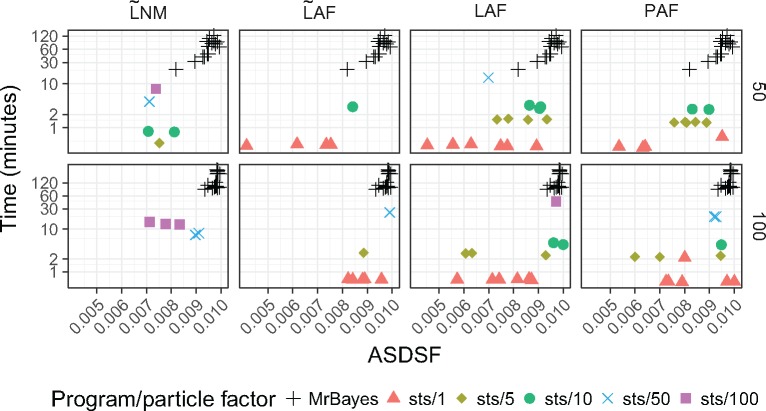
Running time in minutes (on a log scale) to sequentially add five new sequences to a data set of 45 or 95 sequences with MrBayes and \documentclass[12pt]{minimal}
\usepackage{amsmath}
\usepackage{wasysym}
\usepackage{amsfonts}
\usepackage{amssymb}
\usepackage{amsbsy}
\usepackage{upgreek}
\usepackage{mathrsfs}
\setlength{\oddsidemargin}{-69pt}
\begin{document}
}{}$\textsf{sts}$\end{document}. Here \documentclass[12pt]{minimal}
\usepackage{amsmath}
\usepackage{wasysym}
\usepackage{amsfonts}
\usepackage{amssymb}
\usepackage{amsbsy}
\usepackage{upgreek}
\usepackage{mathrsfs}
\setlength{\oddsidemargin}{-69pt}
\begin{document}
}{}$\textsf{sts}$\end{document} is run with particle factors ranging from 1 to 100 and the lowest time reported that achieved an ASDSF less than 0.010. Runs for which no particle factors resulted in an ASDSF less than 0.010 are not shown on the plot. Results are based on five data sets in which the taxa were added in three different orders, resulting in at most 15 data points. For example, the LAF plots contain 14 and 12 data points for data sets consisting of 50 and 100 sequences, respectively (see Supplementary Table S1 available on Dryad for a full description of the other proposals).